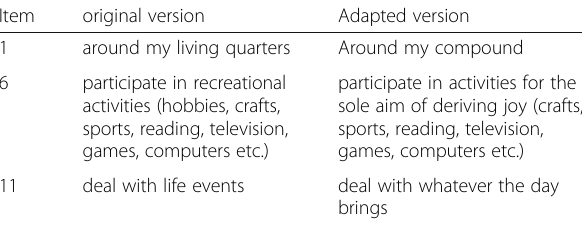
Table 1 Summary of words and phrases modified in adapting the RNLI to Igbo culture and